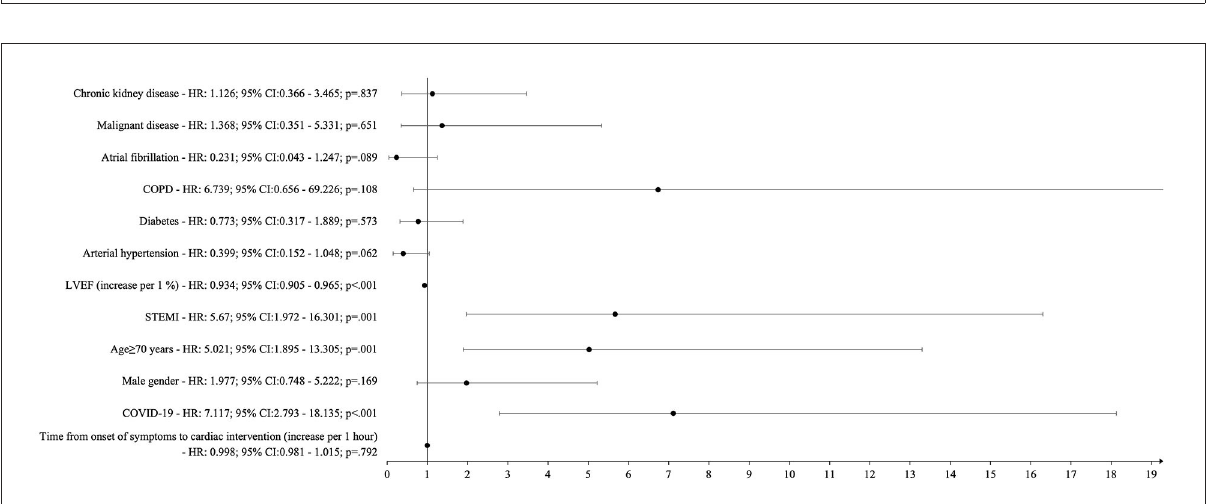
FIGURE2 Cox regression analysis: independent predictors of 30-day mortality. CI, confidence Interval; COPD, chronic obstructive pulmonary disease; COVID-19, coronavirus disease 2019; LVEF, left ventricular ejection fraction; STEMI, ST-elevation myocardial